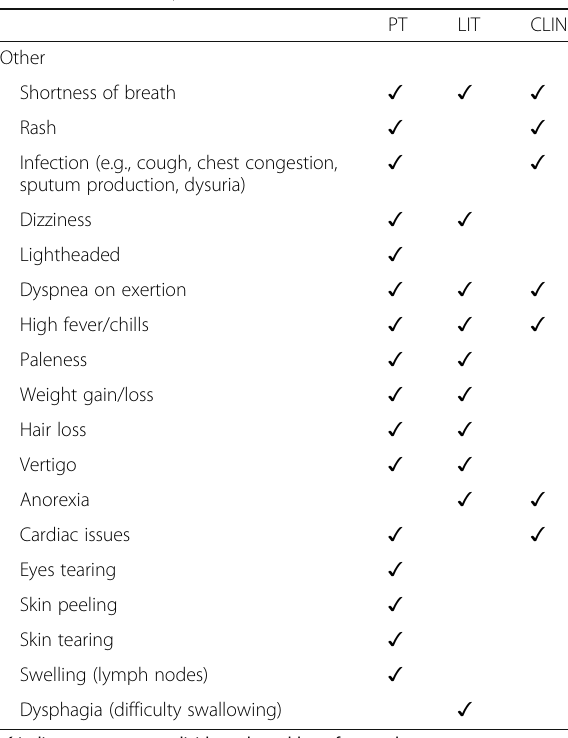
Table 2 Consolidated symptom conceptualization of patient experience with MDS, AML and CMML